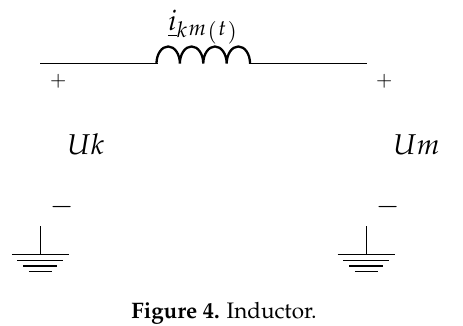
Figure 4. Inductor Figure 4. Inductor.